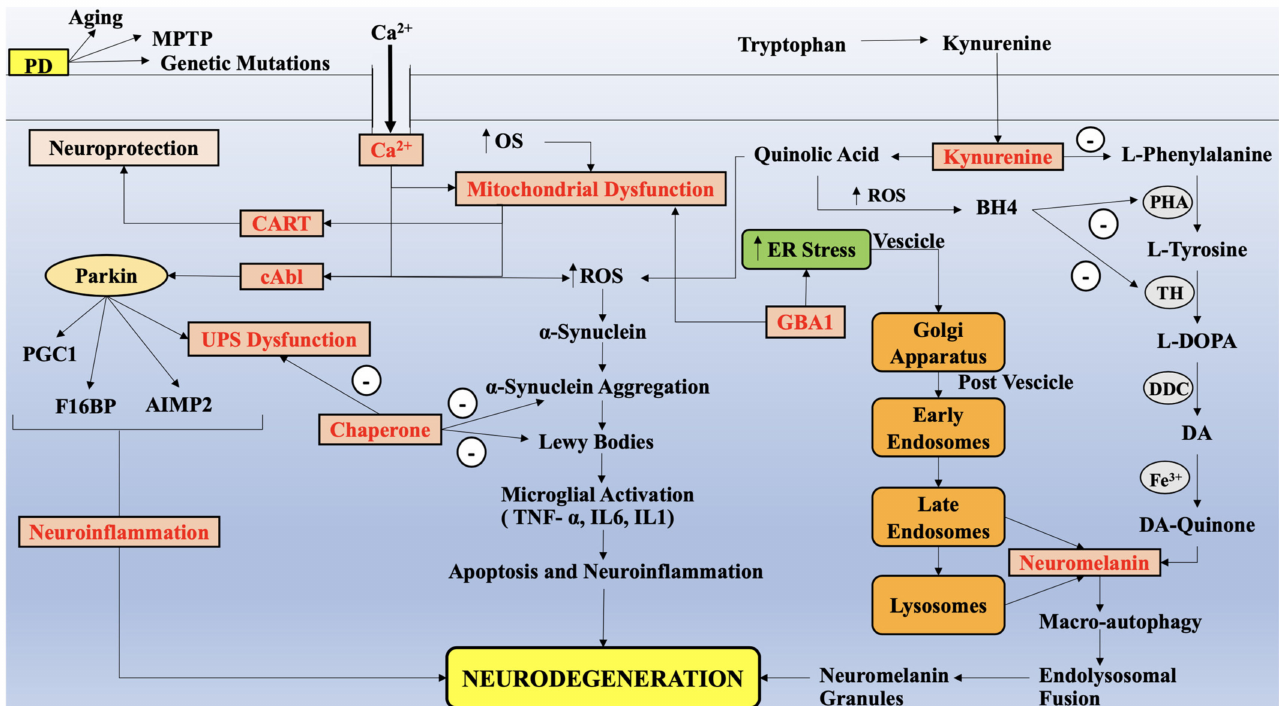
Figure 5. A mechanistic approach of potential targets for the treatment of Parkinson’s disorder (PD). The production of reactive oxygen species (ROS) is initiated by genetic mutations, aging, chemicals, etc., via mitochondrial dysfunction, which intervenes with ubiquitin proteasome system (UPS) and α -synuclein, resulting in the production of Lewy bodies. These further interfere with activation of microglial cells resulting in neuroinflammation and cell death. Calcium influx stimulates mitochondrial dysfunction, which further stimulates protein Abelson (c-Abl), further stimulating Parkin, followed by UPS dysfunction, PGC1, F16BP, and AIMP2. Mitochondrial dysfunction is also stimulated by glucocerebrosidase-1 (GBA-1), which elevated ER stress and aids in formation of neuromelanin pigments, resulting in neurodegeneration and cell death. Kynurenine is transformed to quinolic acid, stimulating tetrahydrobiopterin (BH4) and ROS, where the former blocks dopamine (DA) synthesis by hindering the enzymes, tyrosine hydroxylase (TH), and phenylalanine hydroxylase (PHA). Cocaine–amphetamine regulated transcript (CART) provides neuroprotection by protecting DA neuron. Chaperone binds to α -synuclein and blocks activation of microglia, production of Lewy bodies and UPS dysfunction, ameliorating production of proinflammatory cytokines, preventing cell death. Legend: PD—Parkinson’s disease, ROS—reactive oxygen